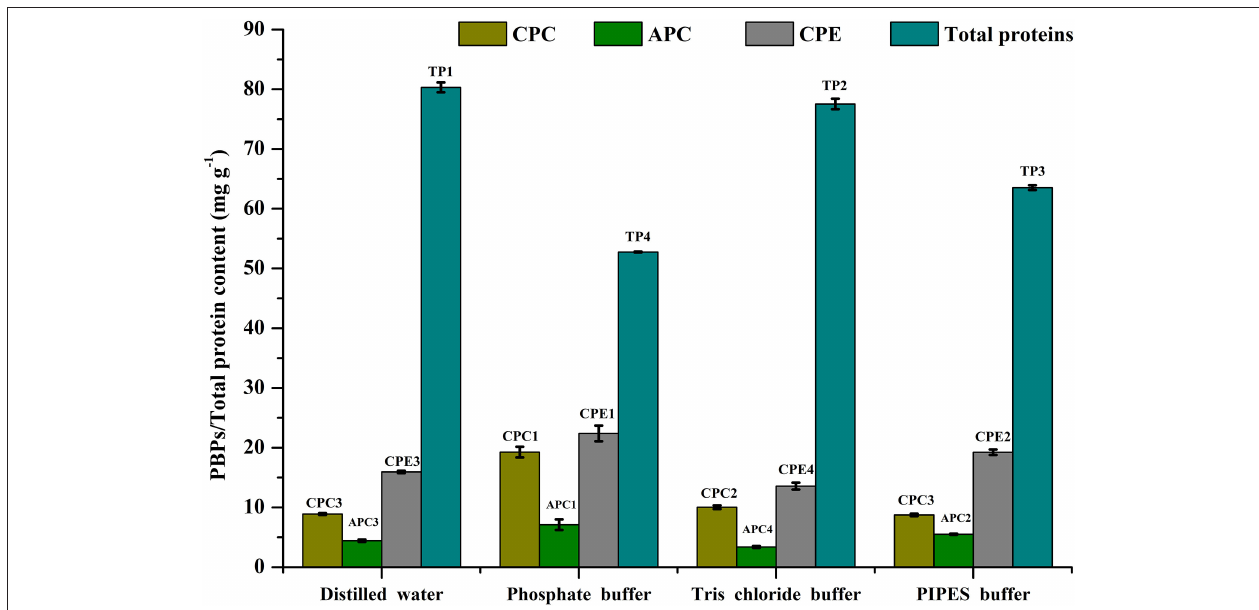
FIGURE 1 | Screening of different buffers for CPE and total protein extraction. pH of all buffers adjusted to 7. Significance of each extracted analyte denoted by its initials followed by significance number. A different number denotes statistical significance ( p < 0.05, n = 3). TP, Total proteins.